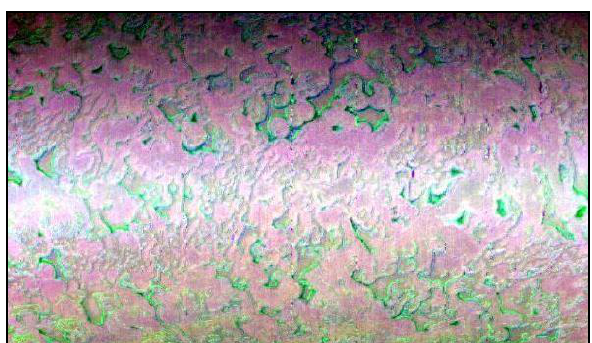
Figure 6: False colour visualisation of CRISM Scene 00005D2 using Pelkey’s spectral summary products. Pelkey, et al., 2007). Red: CO 2 ice, Green: Carbonate Overtones, Blue: Water ice The areas highlighted in green around depression rims, indicating carbonate overtones, are those most likely to contain any possible signatures suggesting organics. Samples from the rims were taken using CAT’s spectra collection function, using a minimum of 20 pixels/region of interest to minimise noise. Figure 7 shows a region of interest, with dark scarps highlighted in blue, and an area of similar size from a featureless part of the SPRC in